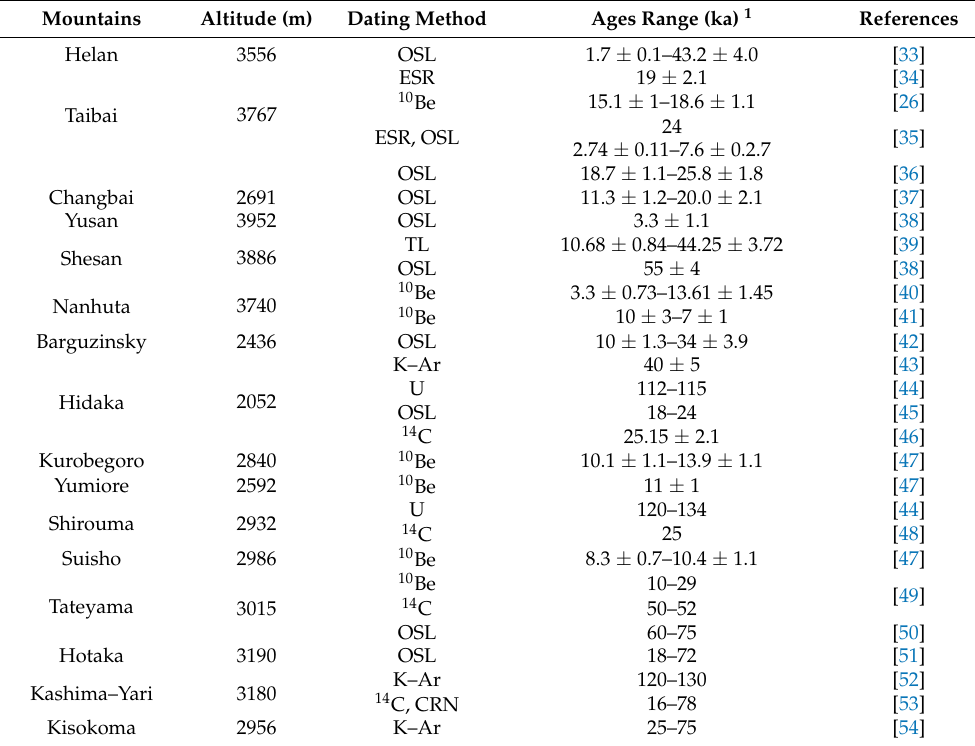
Table 2. Statistical of moraine ages in EAM region. Mountains Altitude (m) Dating Method Ages Range (ka)